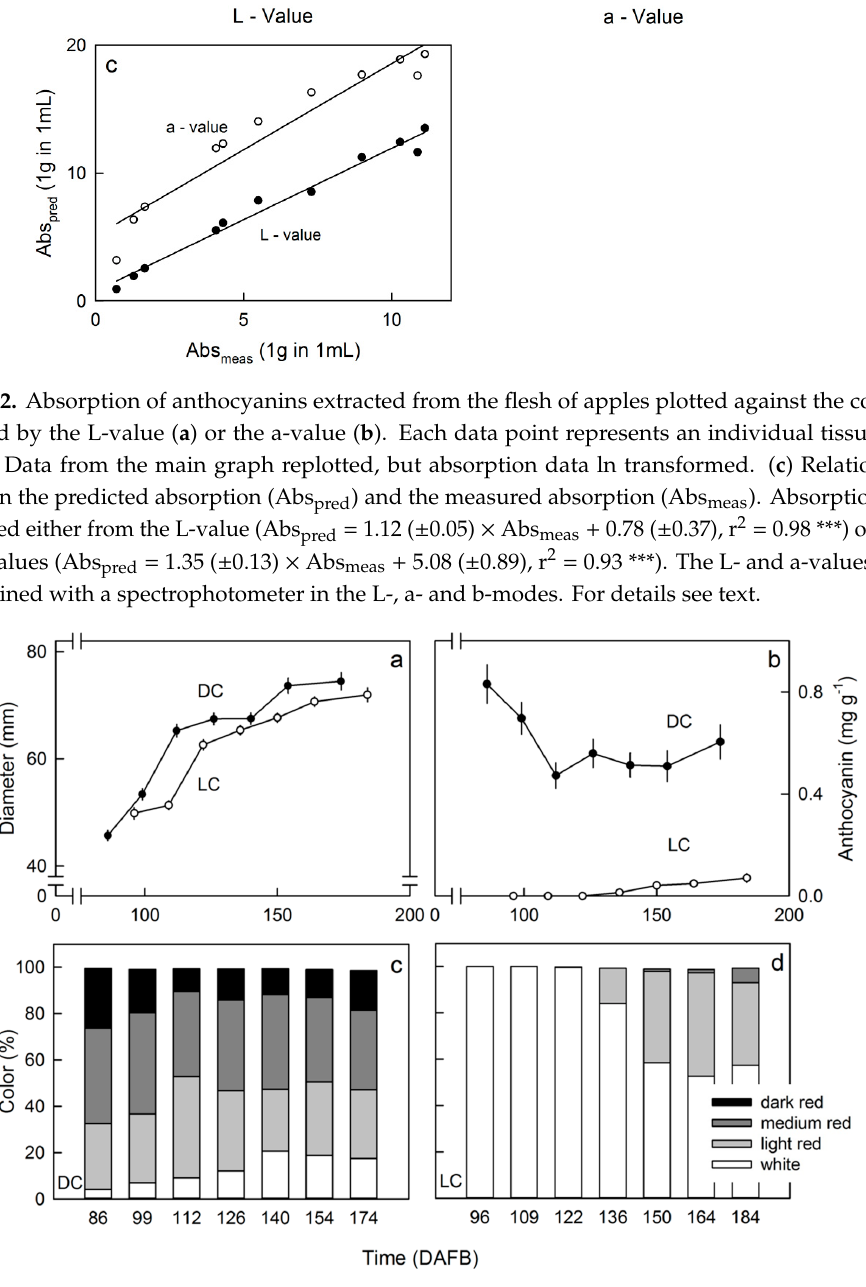
Figure 3. Developmental time course of change in diameter ( a ) and flesh color as indexed by the anthocyanin accumulation ( b ) in red flesh apples of a dark-colored (DC) and a light-colored (LC) clone. Distribution of color classes in DC ( c ) and LC clones ( d ). In both clones, flesh color intensity decreased from top to bottom positions in the tree crown (Figure 4a,b). The color distribution changed analogously (Figure 4c,d). Differences in sun exposure (north vs. south aspect) did not result in significant changes in flesh color (Figure 5). The intensity of flesh color decreased when branches were shaded with hail net (Figure 6a,b). UV-exposure did not affect flesh color in the DC clone (Figure 7a,c) but in the LC clone flesh color decreased significantly when fruit were covered with UV-absorbing film (Figure 7b,d). Compared with light fruit thinning, the medium and heavy fruit thinning both increased the red color in the flesh of both clones, DC and LC (Figure 8). There was no consistent change in flesh color during storage of either clone (Figure 9a). In the DC clone, an increasing proportion of fruit developed severe flesh browning as storage time increased. There was no browning in the LC clone (Figure 9b,c).